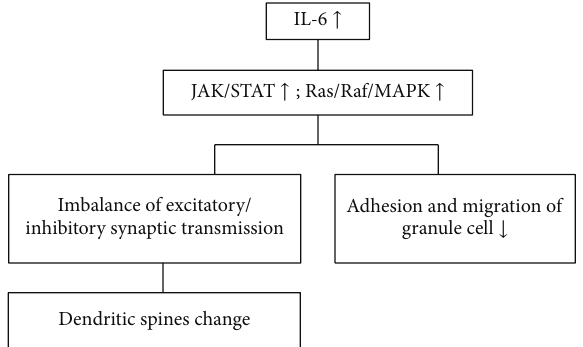
Figure 1: The potential role of IL-6 in the pathogenesis of ASD.